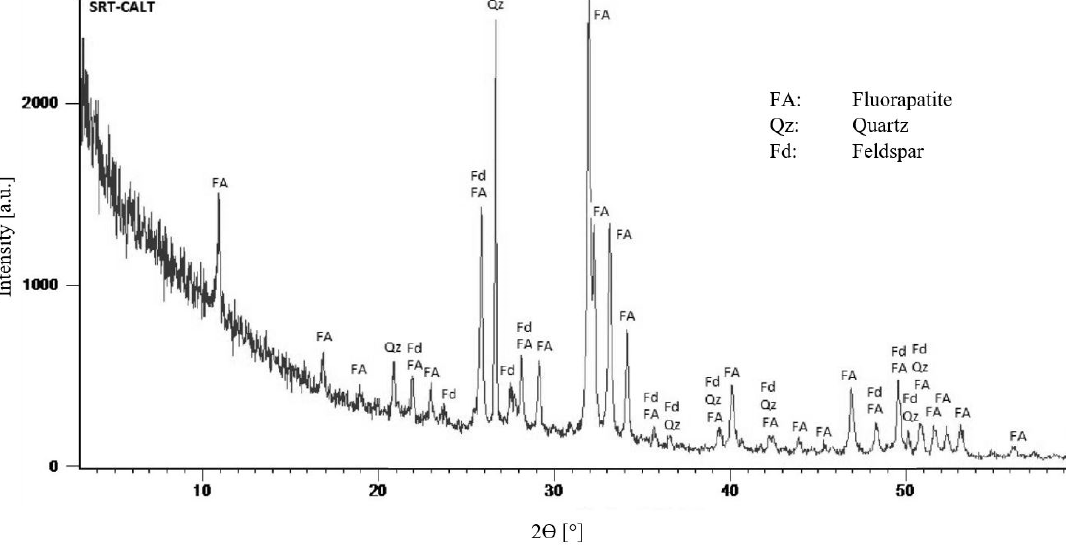
Figure 10. XRD pattern of the calcined and treated Sra Ouertane (layer A1) phosphate rock.